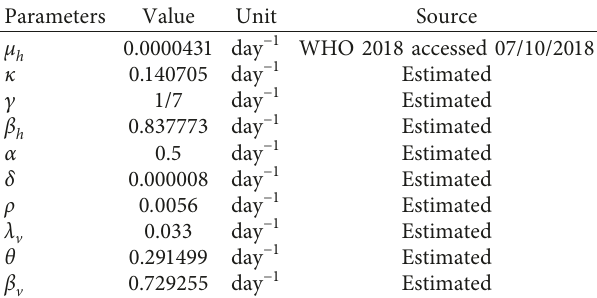
Table 2: Model parameters and values.